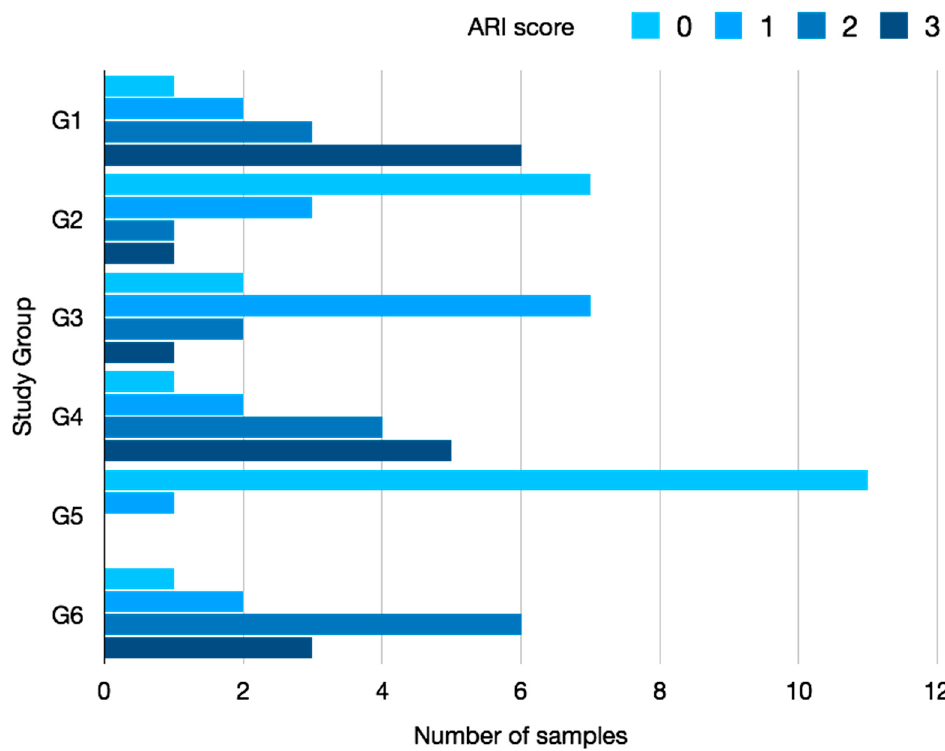
Figure 5. Bar diagram of ARI classification according to groups.